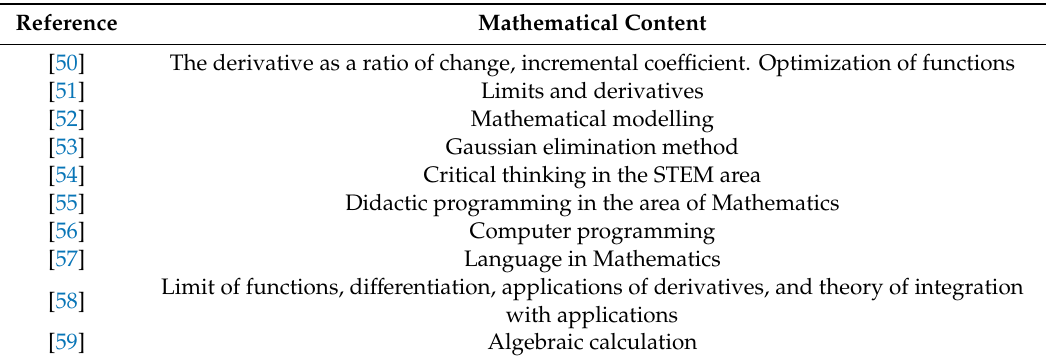
Table 3. Mathematical content covered in each educational experience.